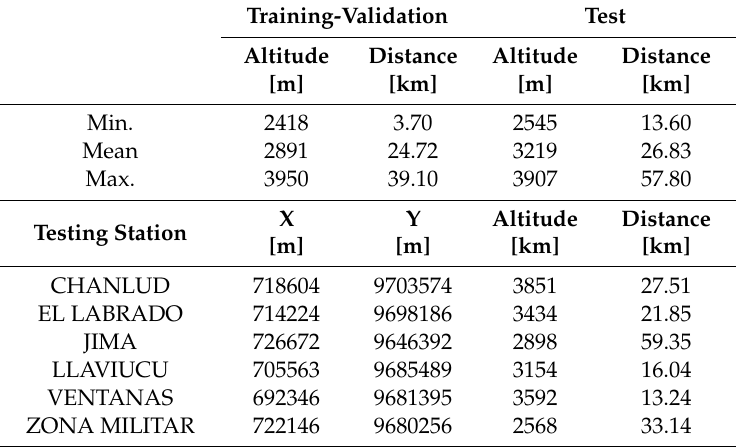
Figure 4. Simplified workflow of the development of the random forest (RF) model for the current study. Table 2. ( a ) Statistics of the altitudes of the rain gauges and its distances from the CAXX radar used at each stage (23 for training-validation and 6 for testing) of the modeling process. ( b ) Further details of the independent rain gauges among the study site that were used for testing the